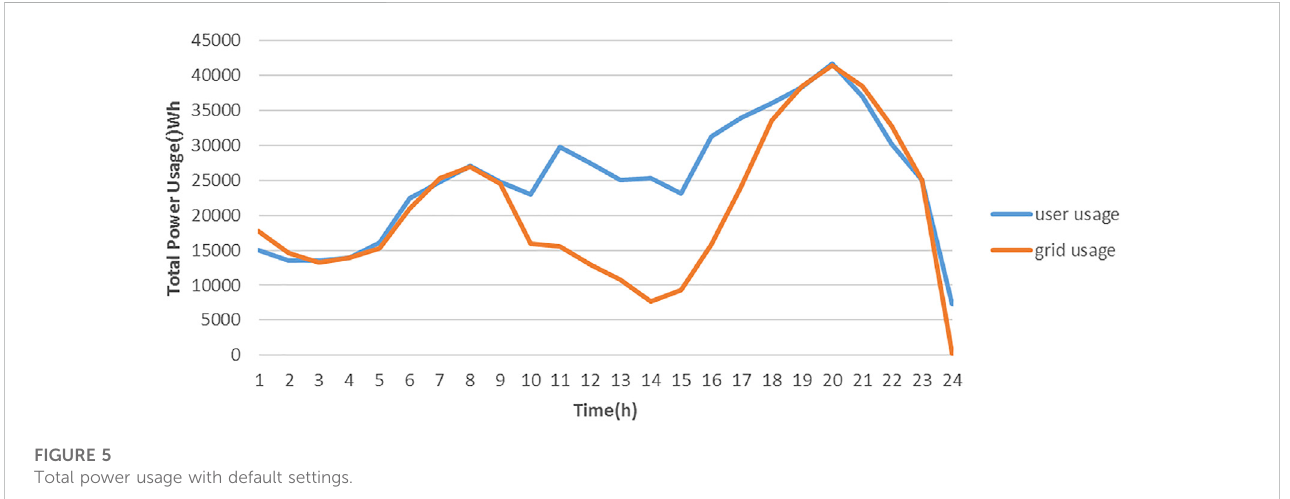
FIGURE 5 Total power usage with default settings.